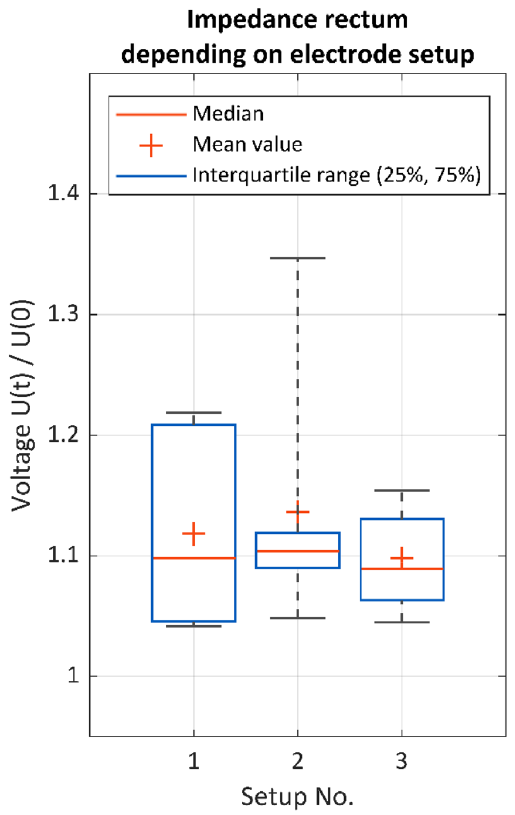
Figure 8. Normalized tissue impedance of the rectum U(t)/U(0) for different electrode setups (case 1–12). Setup 1 (needle electrodes only, n = 12), setup 2 (needle electrodes and surface electrodes, n = 6), setup 3 (surface electrodes only, n = 9), Stimulation parameters: 15 mA, 1000 µs, 30 Hz. Stimulation position: paraproctium with the Saxophone